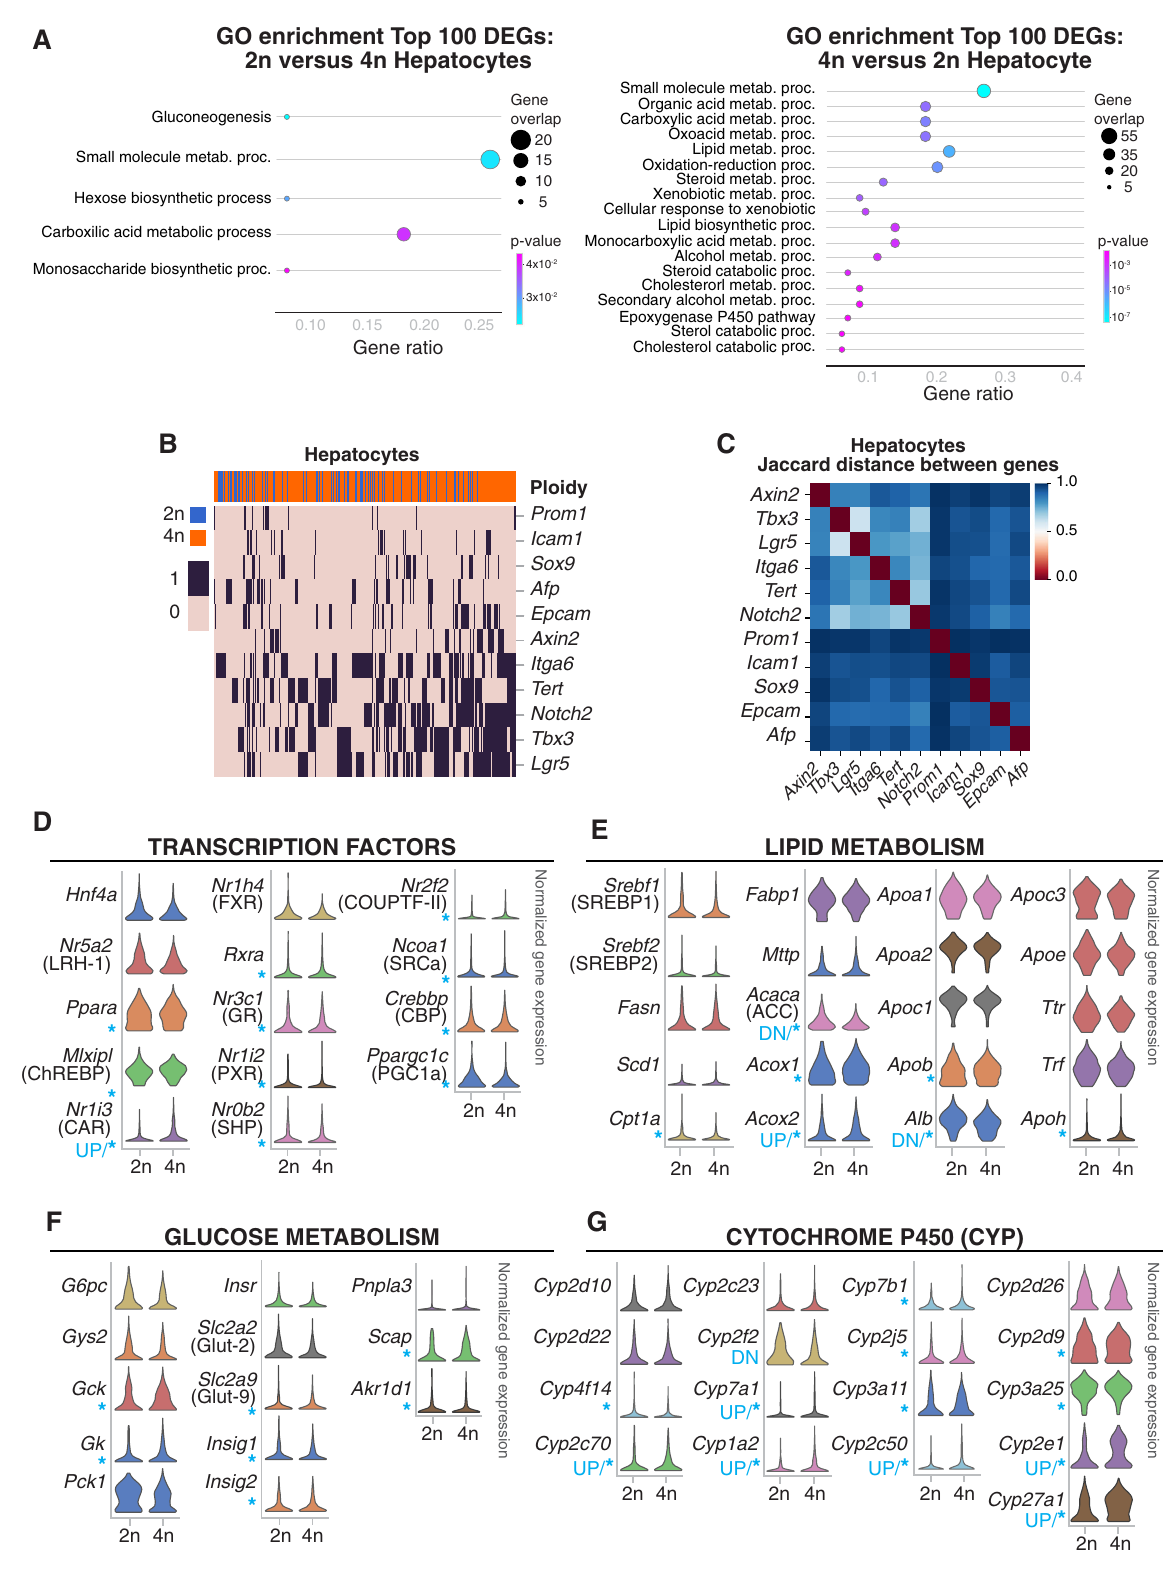
hepatocytes (Fig. 4B and Supp. Fig. 7C). In order to investigate whether these markers were co-expressed in the same nuclei, the Jaccard index was used to measure the probability of those genes being co-expressed in the same nucleus 99,100 . In particular, the Jaccard distance measures dissimilarity between genes, and lower distance indicates a higher probability of co-expression (Fig. 4C).